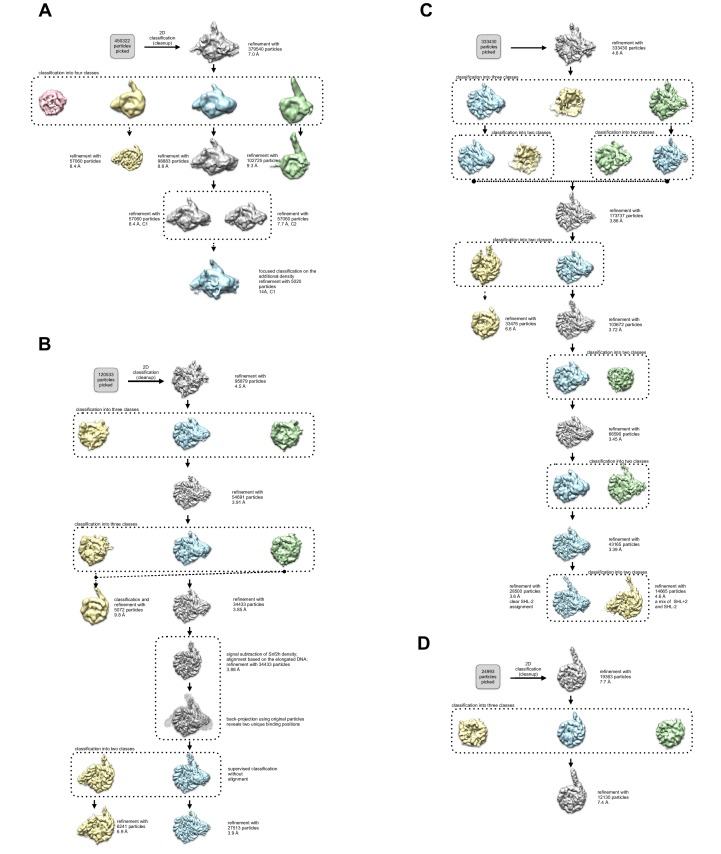
3D Classification and refinement.(A–B, D). The flowchart of classification and refinement procedures using RELION and Cryosparc is shown. Following 1 round of 2D classification, each dataset was subjected to 3D refinement and subsequent classification. (A) Scintillator-based doubly-bound dataset. (B) Direct electron detector-based SNF2h-nucleosome complex dataset that resulted in single-bound flanking DNA proximal and distal complexes as well as unbound nucleosomes. (C) Recalculated direct electron detector-based SNF2h-nucleosome complex dataset, resulting in the 3.4 Å consensus Coulomb potential map. (D) Direct electron detector-based data set for core nucleosome with flanking DNA without added SNF2h.